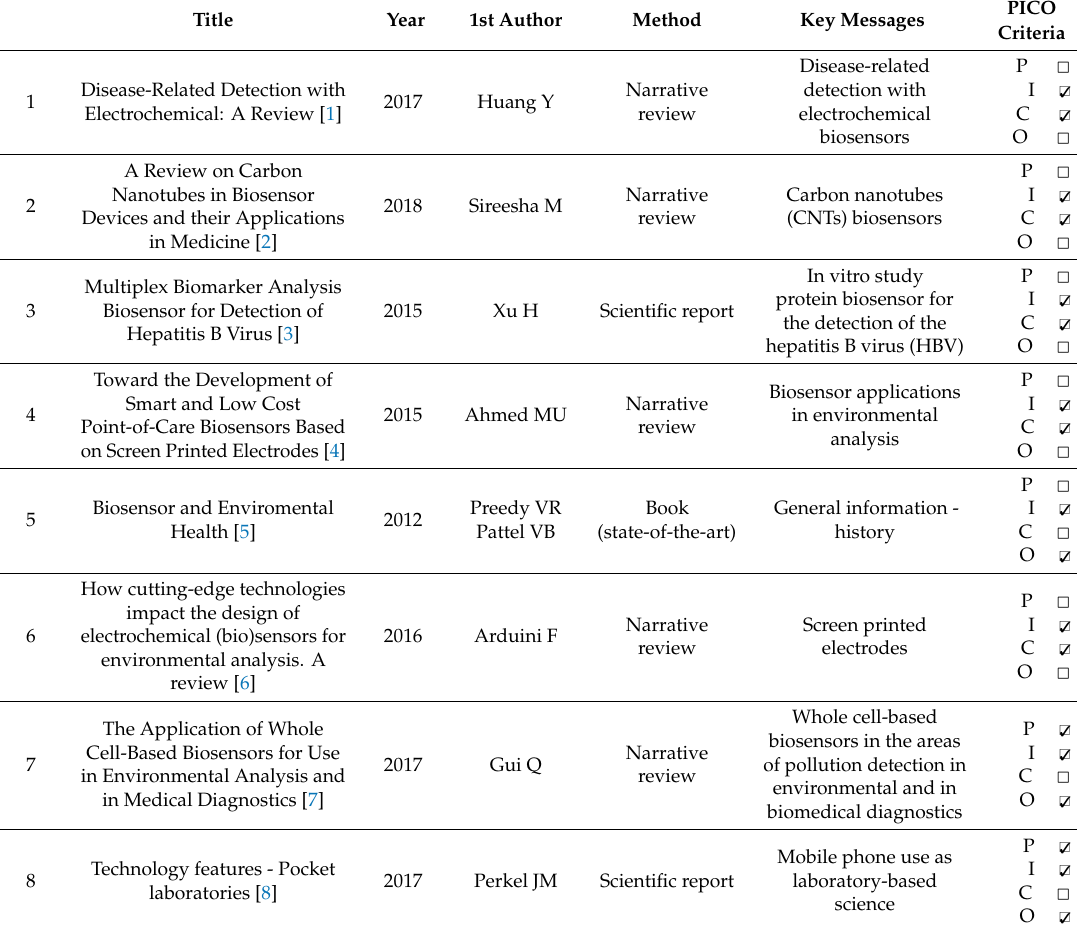
Table 1. Research strategy selected articles.